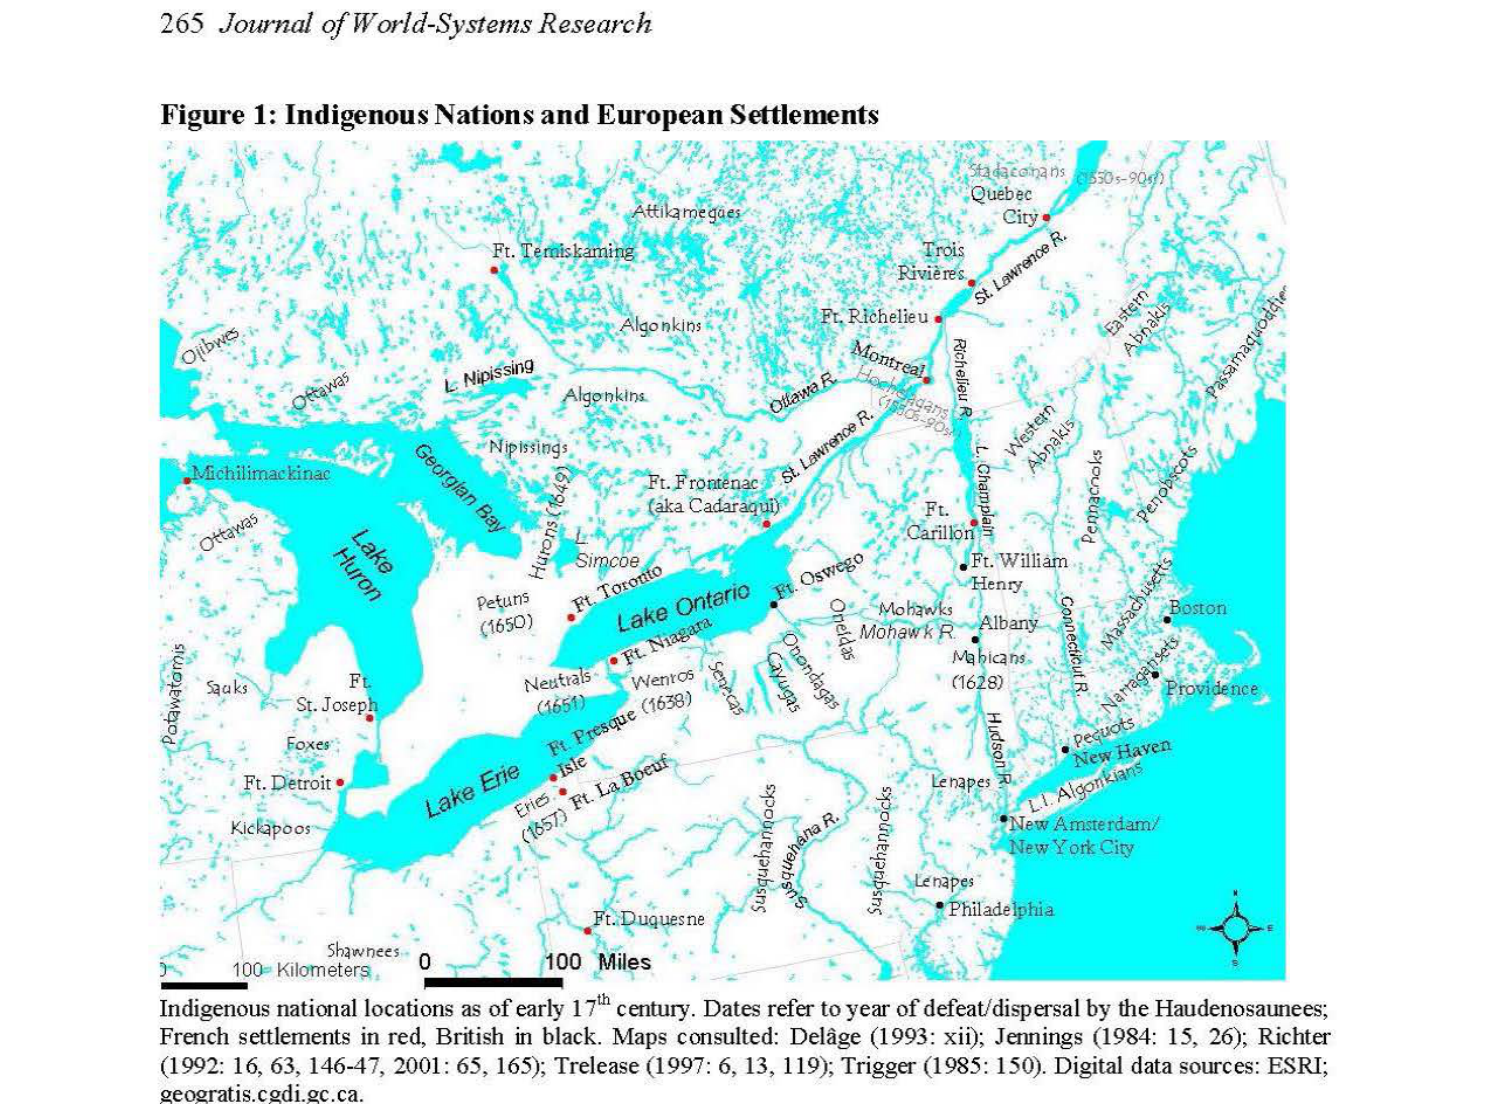
Indigenous national locations as of early 17th century. Dates refer to year of defeat/dispersal by the Haudenosaunees; French settlements in red, British in black. Maps consulted: Delage (1993: xii); Jennings (1984: 15, 26); Richter (1992: 16, 63, 146-47, 2001: 65, 165); Trelease (1997: 6, 13, 119); Trigger (1985: 150). Digital data sources: ESRI; geogratis. c gdi.gc.